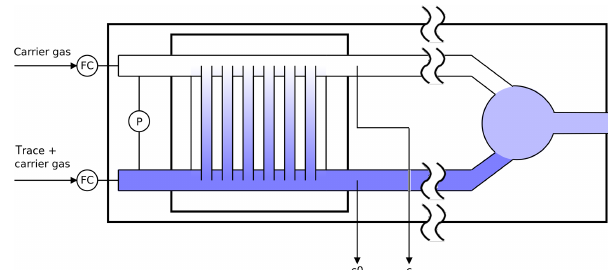
Figure 2. Schematic diagram of the twin tube experiment (not to scale): a diffusion bridge connects two flow tubes. Downstream of the diffusion bridge some gas is continuously sampled for analysis to determine the trace gas concentrations c 0 and c .